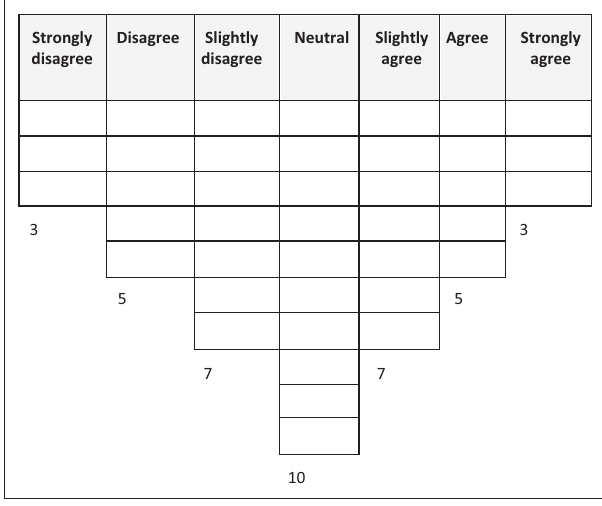
FIGURE 1: Forced-distribution Q-sorting